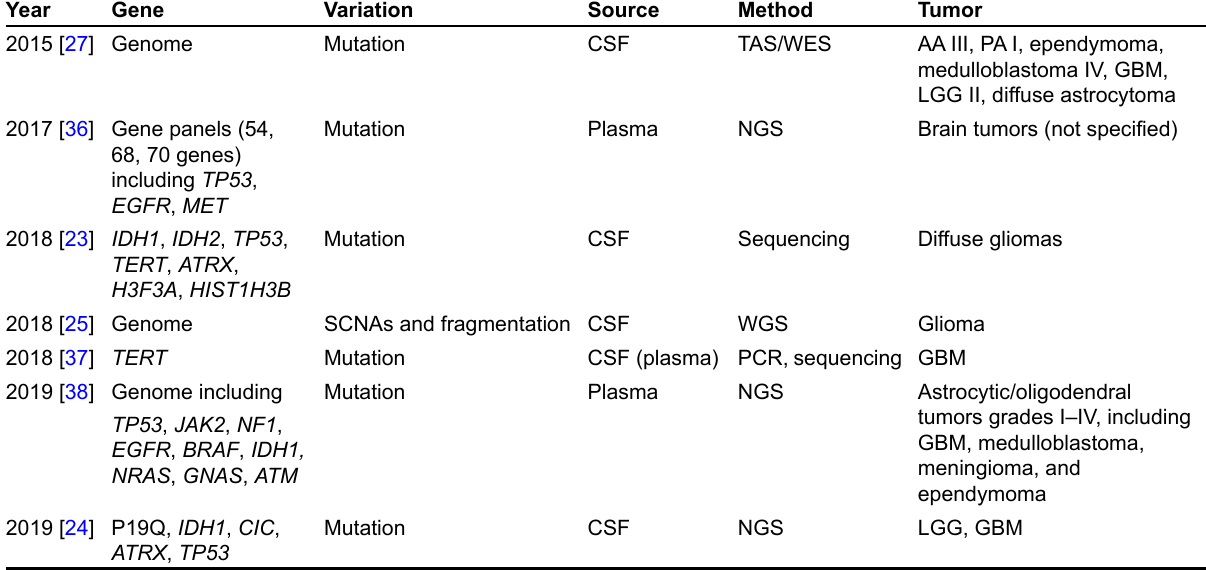
Table 2. Origins of testing ctDNA markers in glioblastomas ( continued )